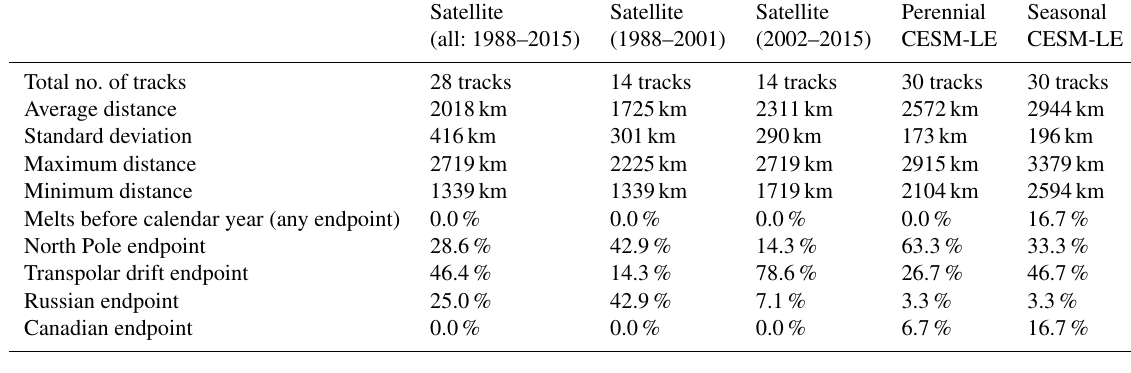
Table 1. Statistics for LITS modeled tracks using satellite observations and seasonal and perennial CESM-LE conditions. The different endpoint regions (illustrated on Fig. 1) are defined with final latitude/longitude values as follows: the North Pole sector (Lat. ≥ 87 ◦ ), the Transpolar Drift sector (Lat. < 87 ◦ , 35 ◦ > Long. > − 60 ◦ ), the Russian sector (Lat. < 87 ◦ , 180 ◦ ≥ Long. ≥ 35 ◦ ), the Canadian sector (Lat. < 87 ◦ , 60 ◦ ≥ Long. ≥− 180 ◦ ).